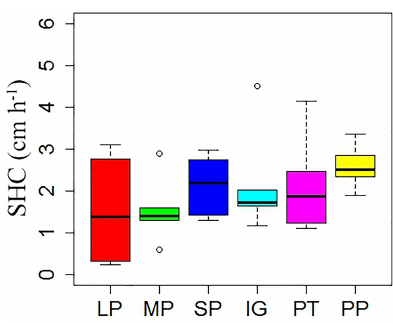
Figure 5. Soil-saturated hydraulic conductivity (SHC) in different surface types: (1) large bald patch (LP), (2) medium bald patch (MP), (3) small bald patch (SP), (4) intact grassland patch (IG), (5) above pika tunnel (PT) and (6) old pika pile (PP).